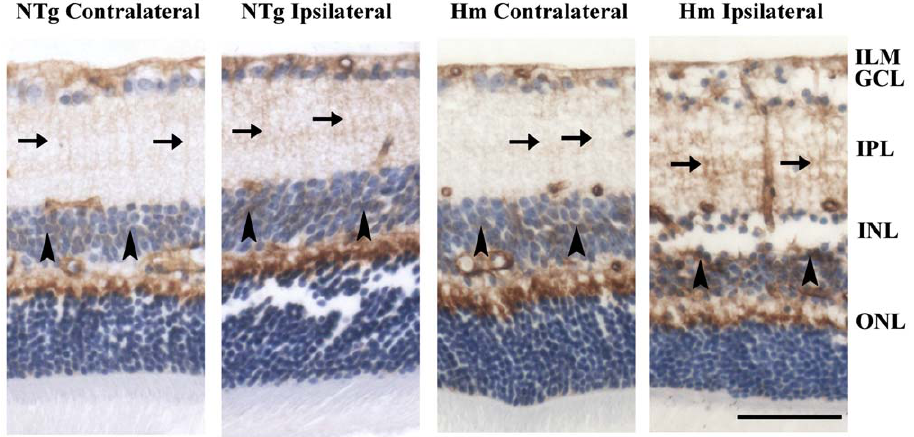
Figure 5. Immunohistochemical staining of aquaporin-4 (AQP4). Up-regulation of AQP4 signal was found in the Mu¨ller cell processes in IPL (arrows) and Mu¨ller cell bodies in INL (arrowheads) in the ipsilateral retina of Hm TET-1 mice compared with the corresponding contralateral retina, while similar intensity of AQP4 signal was present in the contralateral and ipsilateral retinae of NTg mice. n=5 for each experimental group. Scale bar=50 m